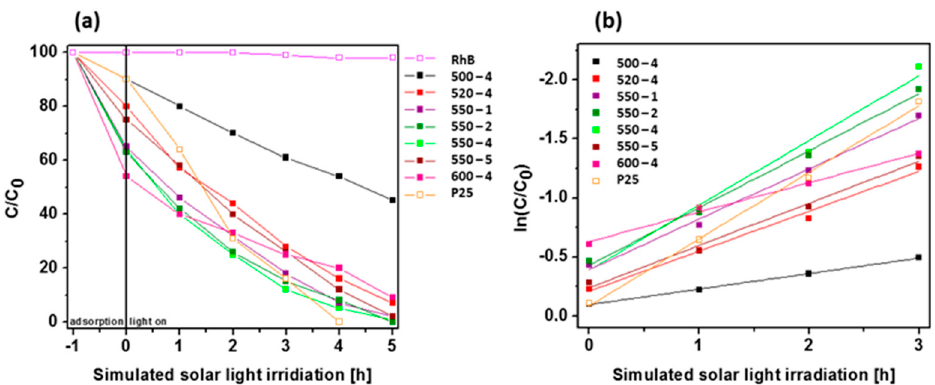
Figure 7. ( a ) Photodegradation of Rhodamine B (RhB) as a function of irradiation time over polymeric carbon nitride synthesized under different conditions. Reactions were performed under simulated solar light irradiation. ( b ) Relationship between RhB degradation efficiency and light irradiation time. Table 5. Photocatalytic RhB decomposition kinetic parameters.